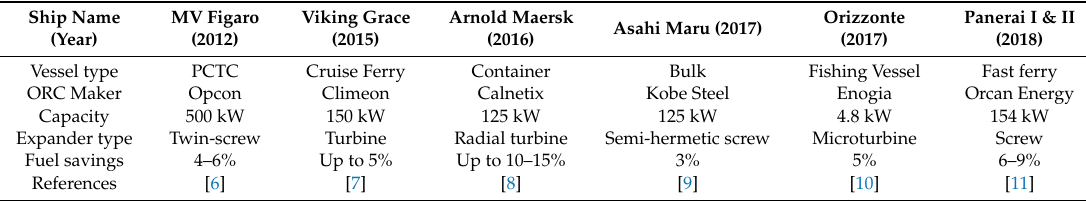
Table 1. List of reported maritime applications of Organic Rankine Cycle plants. 61